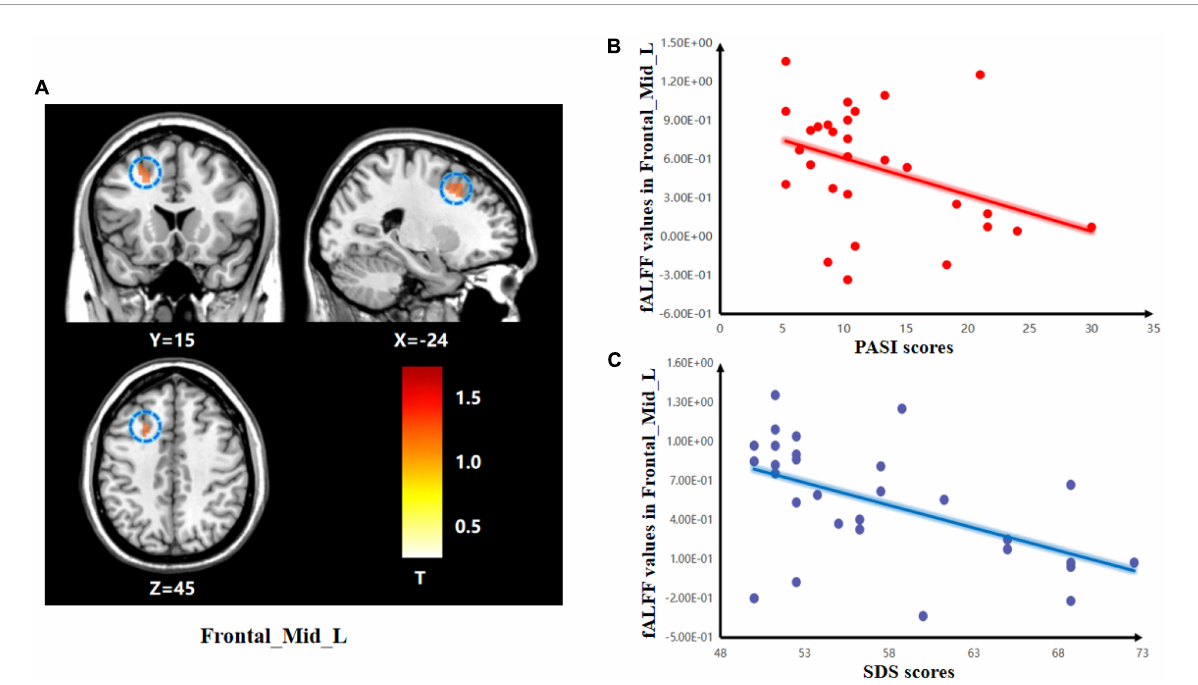
FIGURE1 Group differences in the relationships between brain activity and clinical symptoms. (A) The two-sample t -test showing significant differences in z-standardized fractional amplitude of low-frequency fluctuations (zfALFF) between the two groups. The color bar indicates T -values. Correlations between abnormal fractional amplitude of low-frequency fluctuation (fALFF) and PASI and SDS scores. (B) Negative correlation between the fALFF values in the Frontal_Mid_L and the PASI scores; (C) Negative correlation between the fALFF values in the Frontal_Mid_L and the SDS scores.